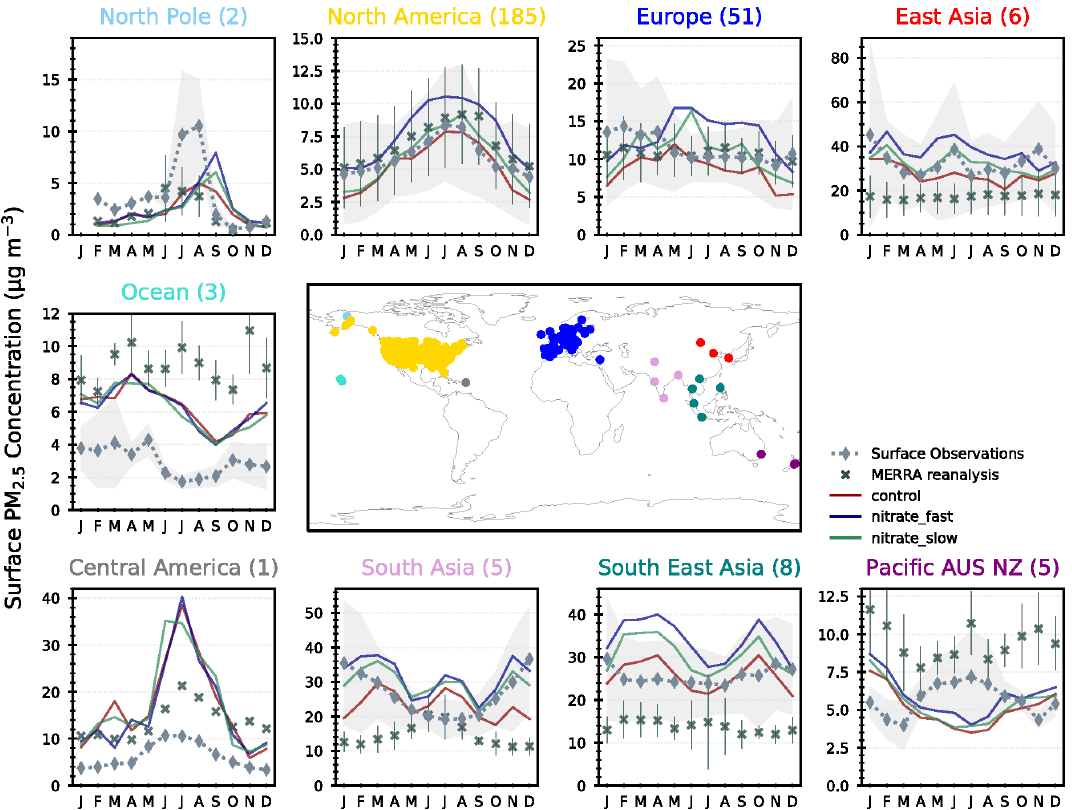
Figure 8. Regional and monthly-mean surface PM 2 . 5 concentrations in the UM simulations (CNTL = red, FAST = blue, and SLOW = green lines), and from MERRA reanalyses and GASSP surface